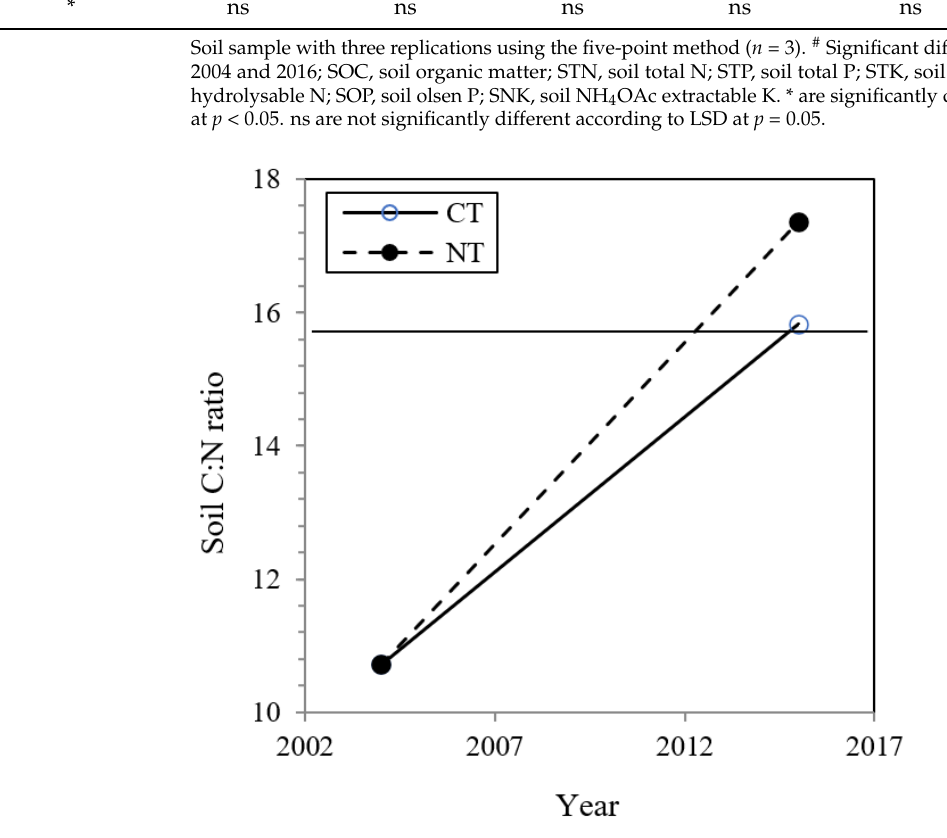
Figure 1. Variation in the soil carbon: nitrogen (C:N) ratio under CT and NT management in a rice–oilseed rape cropping system from 2004 to 2016. Table 2. Variation of 0 ‐ 60 cm soil layer soil chemical properties in 2016.